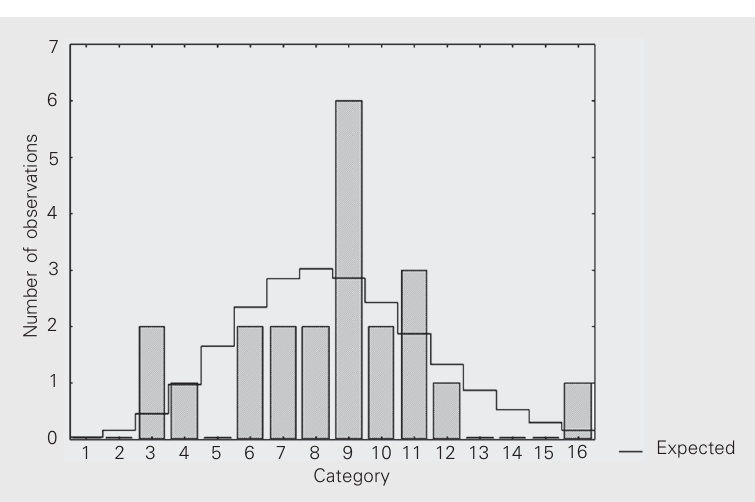
Figure 1. Distribution of baseline micronuclei among individuals aged on average 23.6 years (Kolmogorov-Smirnof test, d = 0.11,